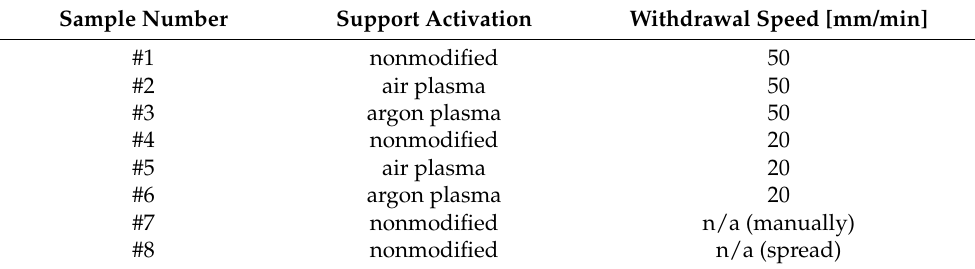
Table 2. Parameters of individual